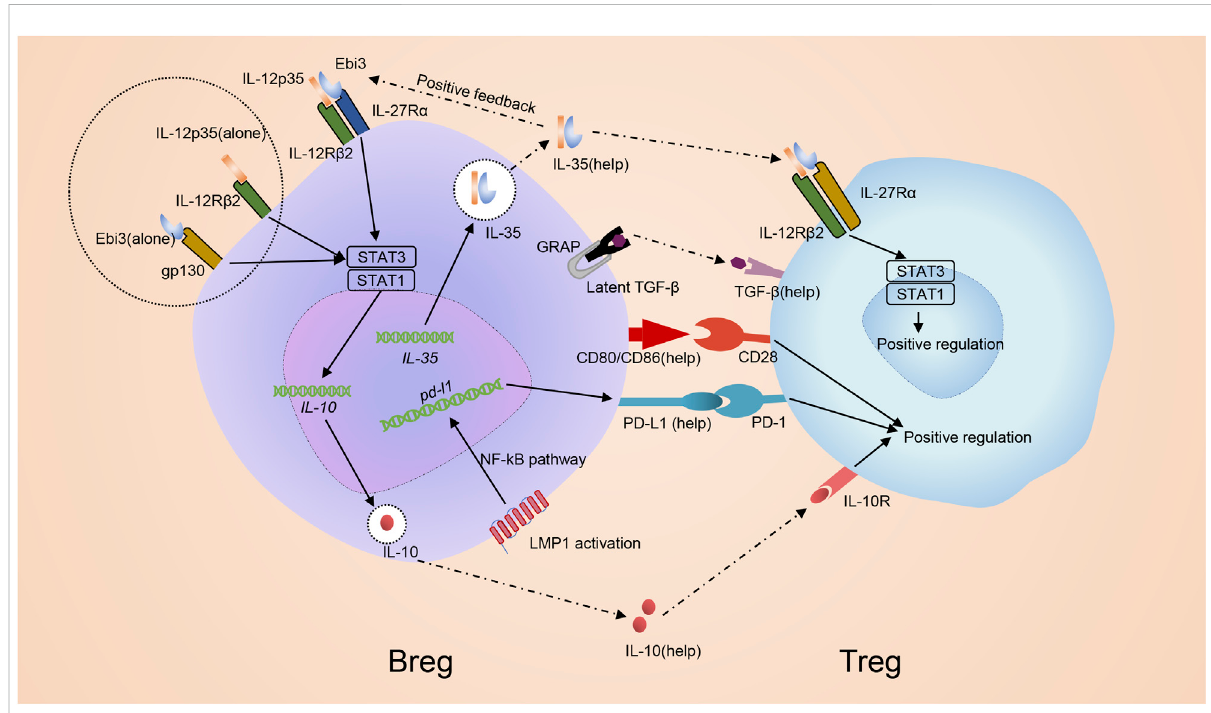
FIGURE 5 MechanismofinducingregulatoryTcellsbyregulatoryBcells.BregspromotedevelopmentofTregsviabothcell:cellcontactwithCD4 + Tcells andthesecretionofimmunomodulatorycytokines.IL-35promotesthedifferentiationofBregsthroughstimulatingSTAT1/STAT3viabindingpairing ofIL-35receptorIL-12p35andEbi3orbindingsubunitIL-12p35andEbi3alone.BregsthemselvescanproduceIL-35andpromoteTregsinanIL-35- mediated manner. IL-35 receptor in Treg, which is composed of an IL-12R β 2/gp130 heterodimer, is activated to induce STAT1-and STAT4- signalingtobene fi tTregs.Besides,Bregscanalsosecretotherimmunoregulatorycytokines,inparticularIL-10togetherwithTGF- β ,toregulateTreg. Additionally,co-stimulatorymoleculesCD80/CD86arealsocriticalforBregstopromotedevelopmentofTregs.BregcangeneratePD-L1duetothe MAPK/NF- κ B pathway by LMP1 and advance the growth of Tregs via PD-L1/PD-1